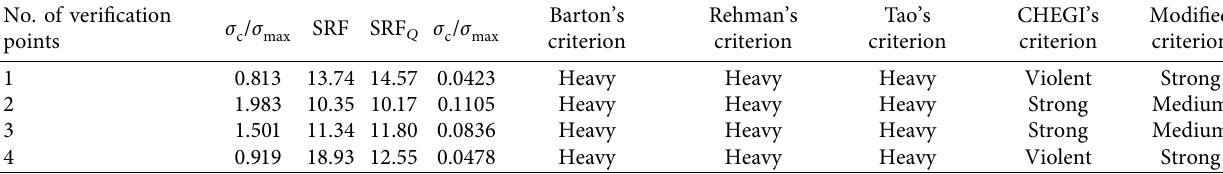
Table 15: Estimation results of various